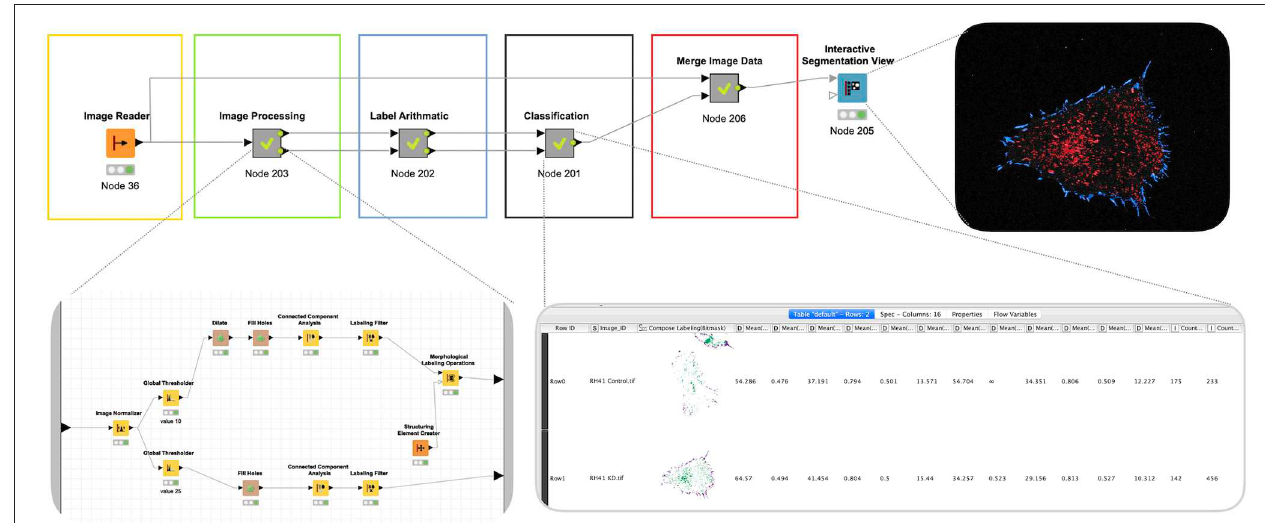
FIGURE 5 | Quantitative analysis of subcellular structures. To analyze the consequences of disrupting the cytoskeleton on matrix adhesion focal adhesion complex formation is visualized using total internal reflection fluorescence (TIRF) imaging. A KNIME workflow was leveraged to define the number of focal adhesion complexes at the periphery of the cell vs. within the center of the cell using sequential steps with discrete objectives: (I) Read file in, (II) processing of the images into labels that capture the individual focal adhesion complexes, (III) arithmetic on the labels to obtain the characteristics (features) for classification, (IV) classification of the labels using extracted features, and (V) visualization of the classified focal adhesion complexes (periphery vs. center). Note that the output of this pipeline is a combination of visualization and quantitation. Both of these can be leveraged for further analysis.